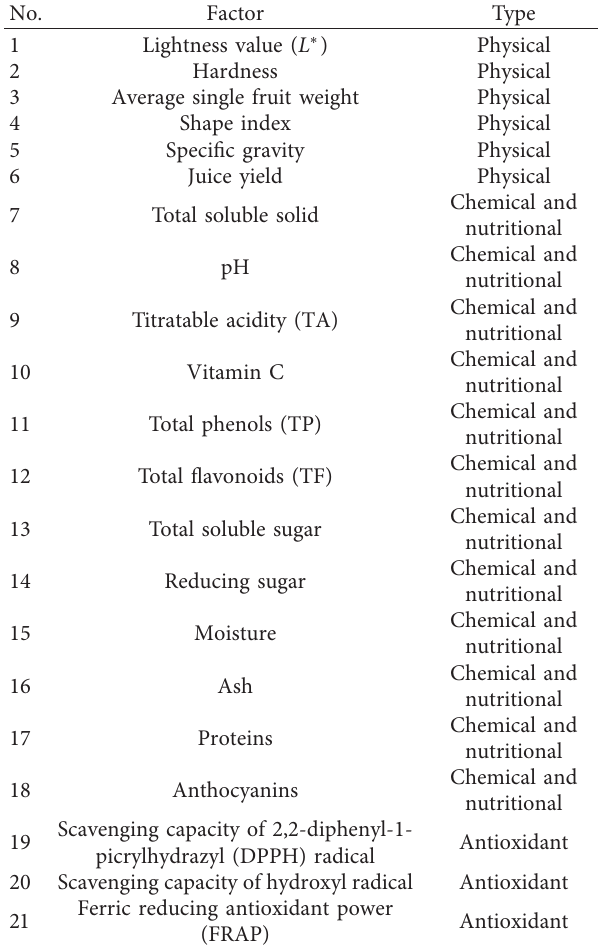
Table 2: The 21 quality factors measured for blueberry fruit.